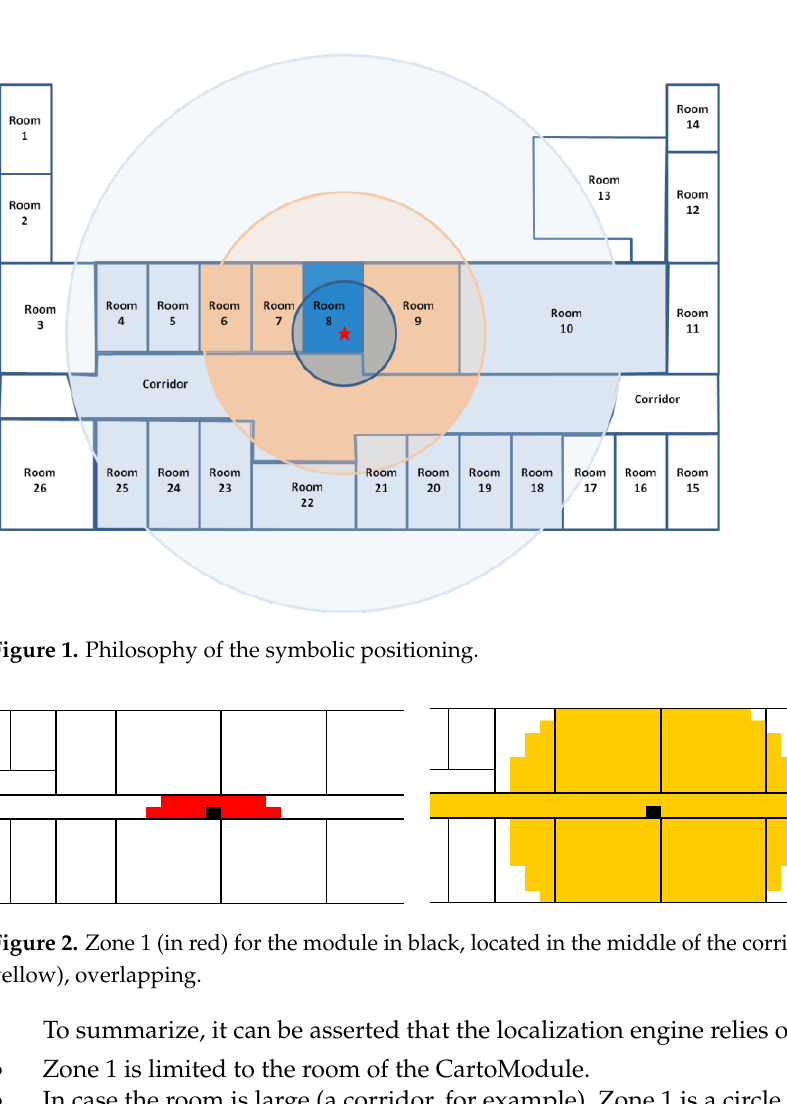
Figure 2. Zone 1 (in red) for the module in black, located in the middle of the corridor, and Zone 2 (in yellow), overlapping.